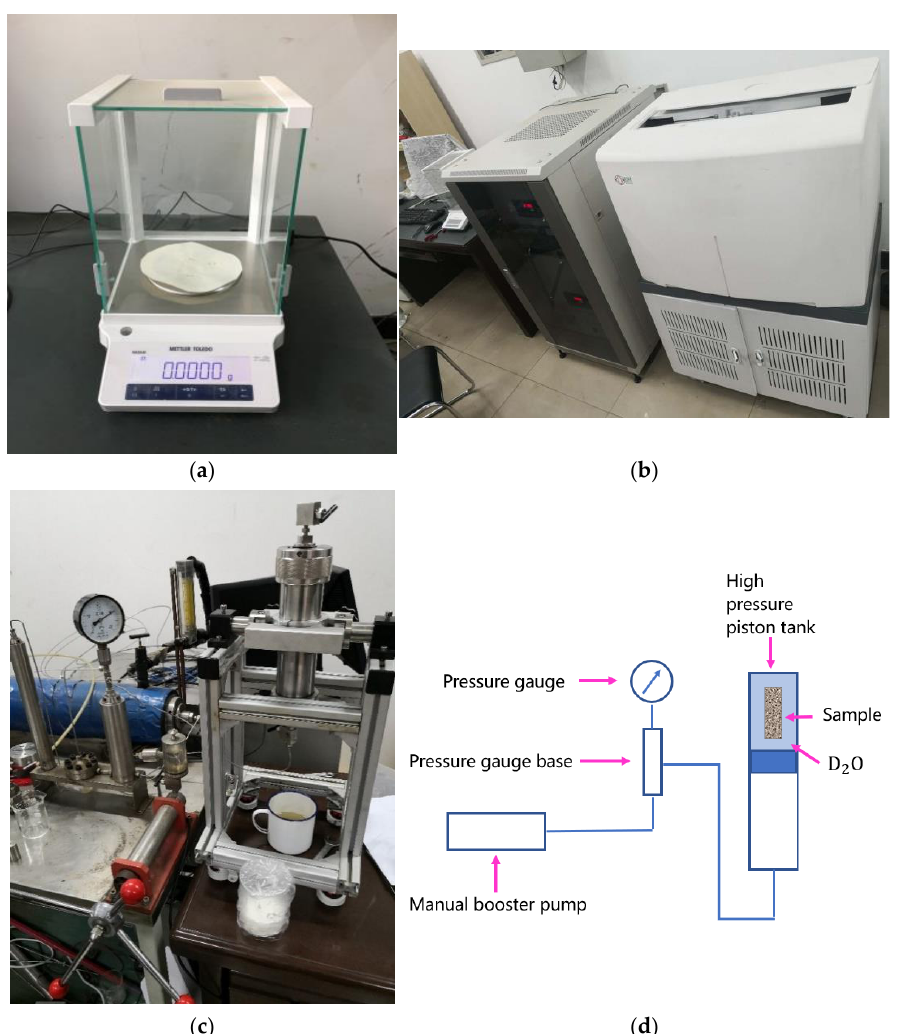
Figure 2. The apparatus used in the experiments. ( a ) Imbibition setup; ( b ) Photo of NMR; ( c ) Manual pressure device; ( d ) Schematic diagram of manual pressure device.